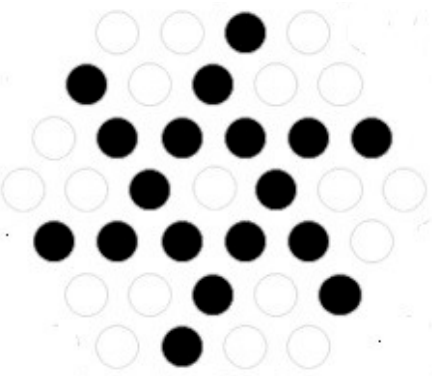
Figure 2. A scheme to make a stack of silica rods and capillaries.